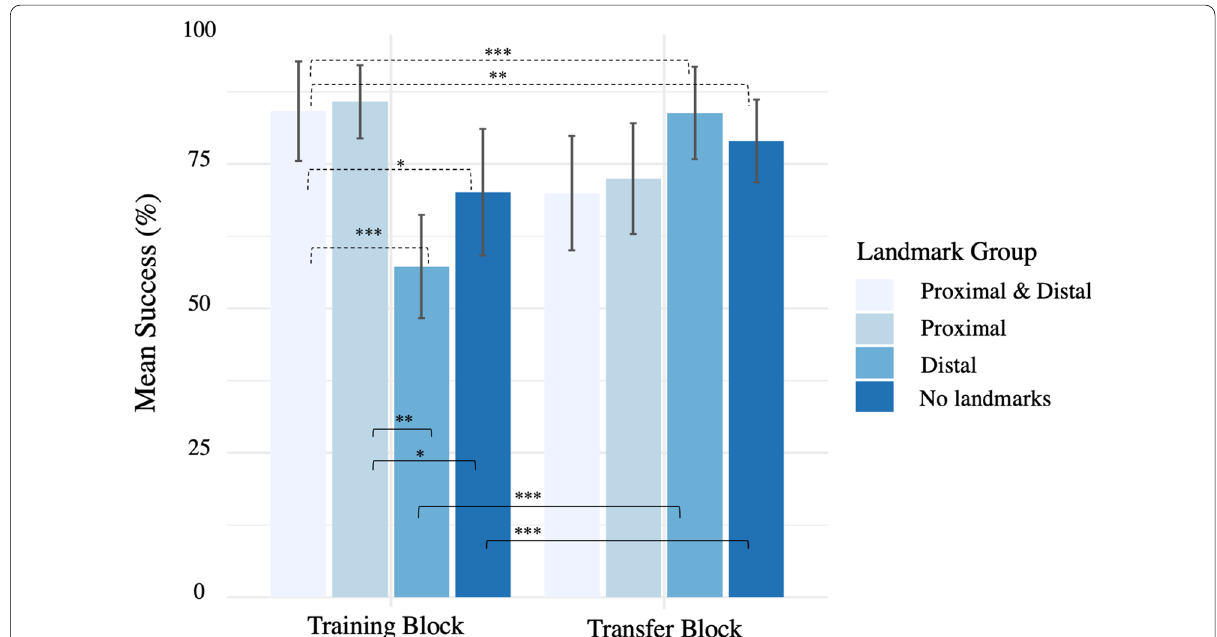
Fig. 3 Success for each Landmark group and Block. Error bars are 95% confidence intervals. Black dashed lines indicate significant model interactions and black solid lines indicate significant pairwise comparisons. Asterisks “***”, “**”, and “*” denote p < .001, p < .01, p < .05,